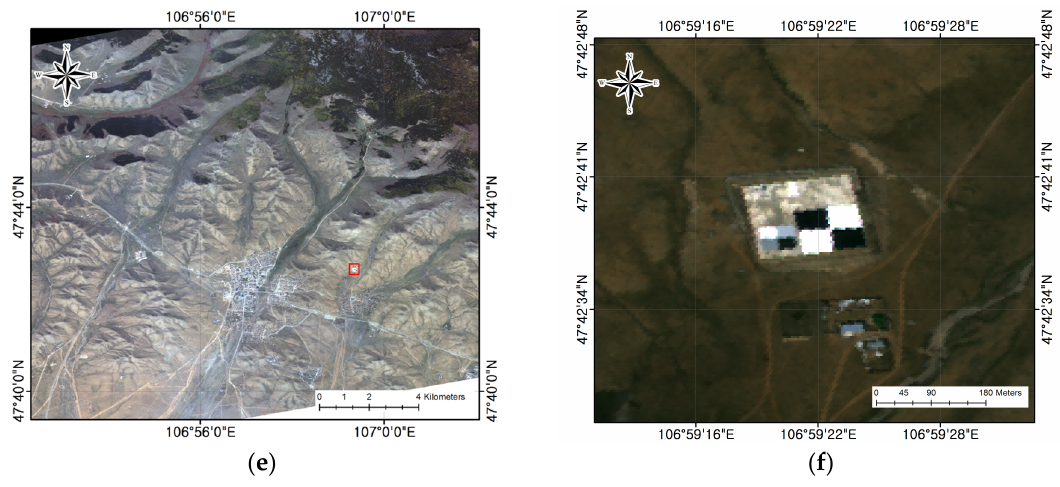
Figure 1. ( a , c , e ) KOMPSAT-3 and -3A RGB images of Goheung County, South Korea acquired on 14 May 2017, Naju, South Korea acquired on 27 July 2017, and Zuunmod, Mongolia, acquired on 19 September 2017, respectively. ( b , d , f ) cropped satellite RGB images showing the locations of the deployed four radiometric tarps corresponding to red squares in ( a , c , e ) respectively.